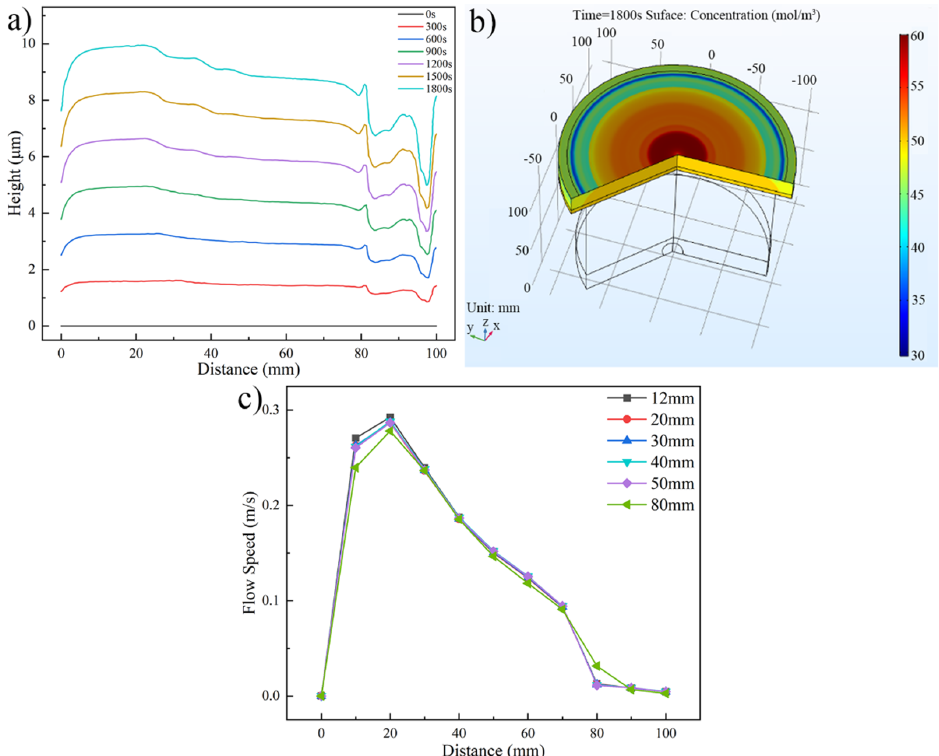
Figure 8. Distributions of the Au bump height, Au+ concentration, and flow speed. ( a ) Au bump height distribution along the wafer radius (Ti wire mesh height is 12 mm), ( b ) Au+ concentration distribution on the wafer surface (Ti wire mesh height is 12 mm), and ( c ) flow speed distribution on the wafer surface at different Ti wire mesh heights.